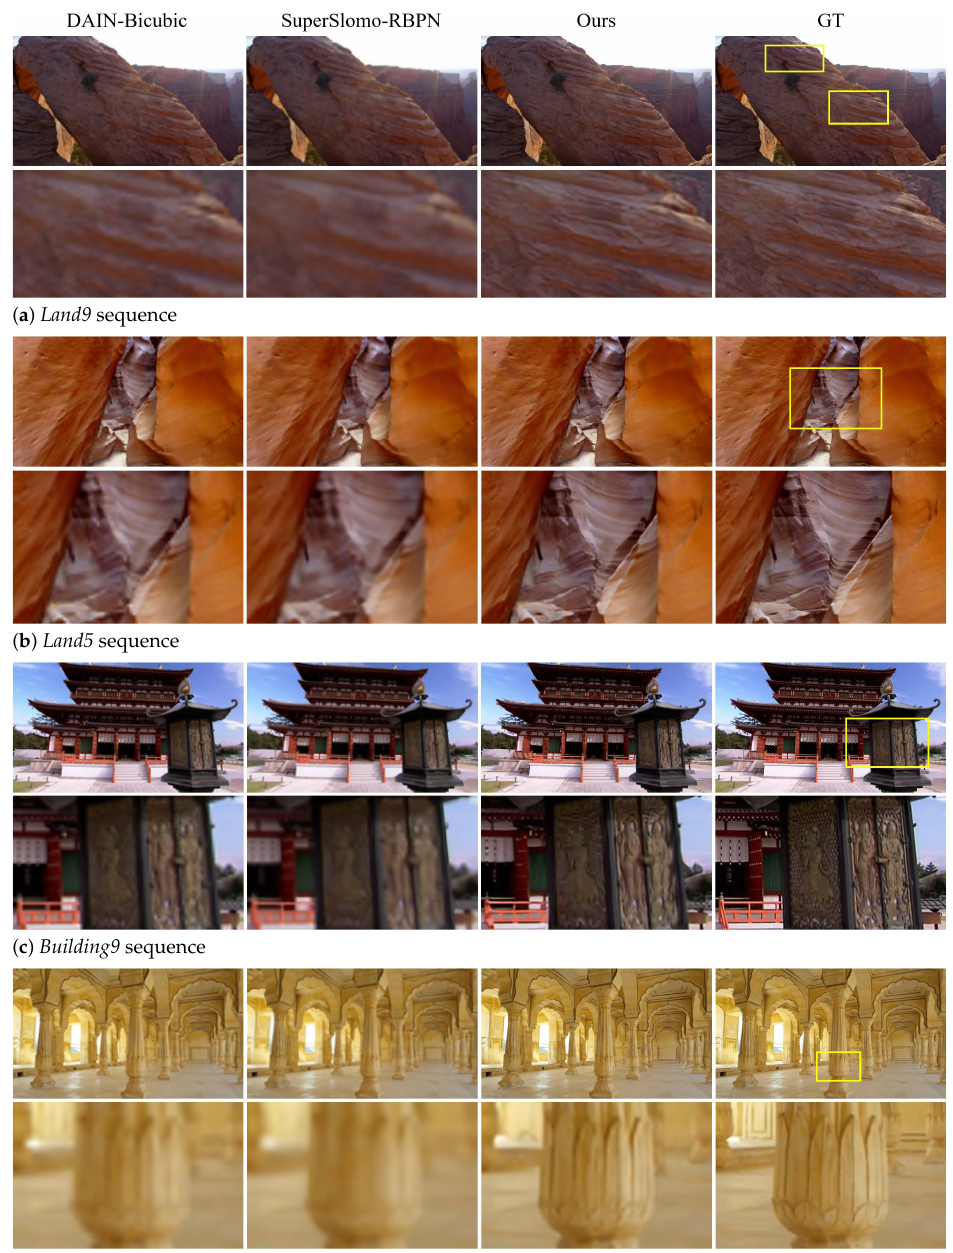
Figure 5. Comparison on the SPMCS dataset. We provide comparison to DAIN-Bicubic and SuperSlomo-RBPN for reference. The magnified regions are denoted as yellow